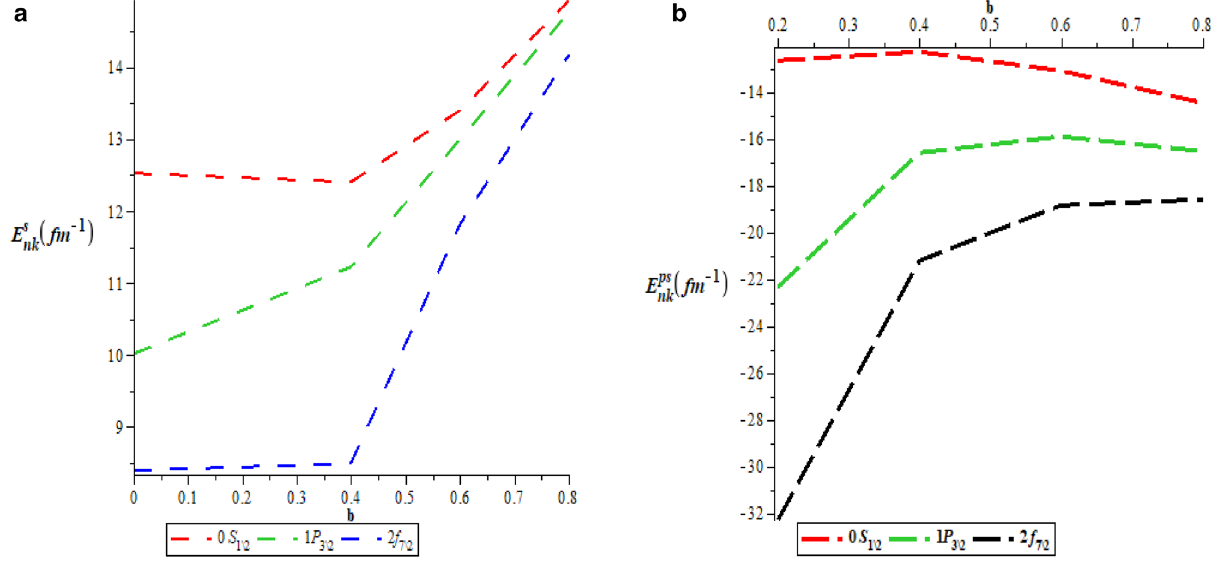
Figure 4. ( a ) Variation of Energy Spectra for Mixed Quantum spin. ( b ) Variation of Energy Spectra for Mixed Pseudo Quantum spin.